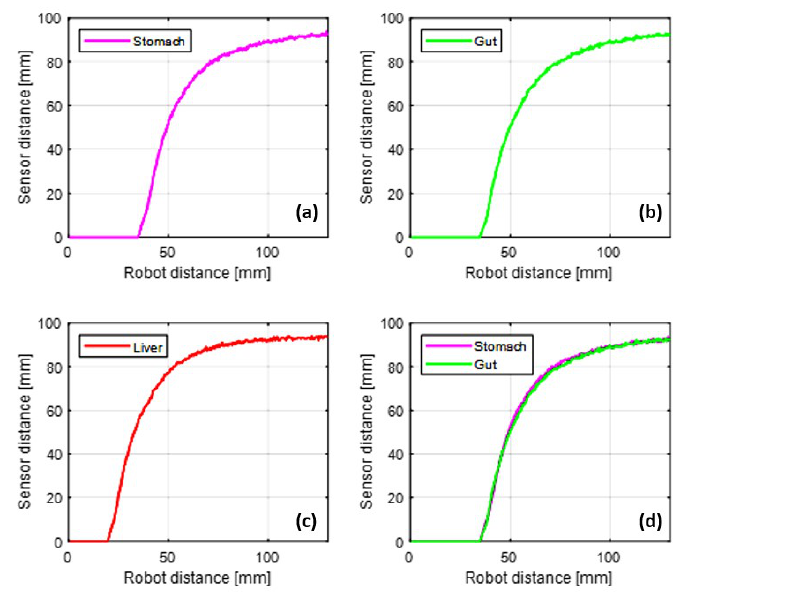
Figure 14. Characteristic curves relating to the proximity of the three tissues analyzed. ( a ) Stomach. ( b ) Gut. ( c ) Liver. ( d ) Superposition of the curves of the intestine and